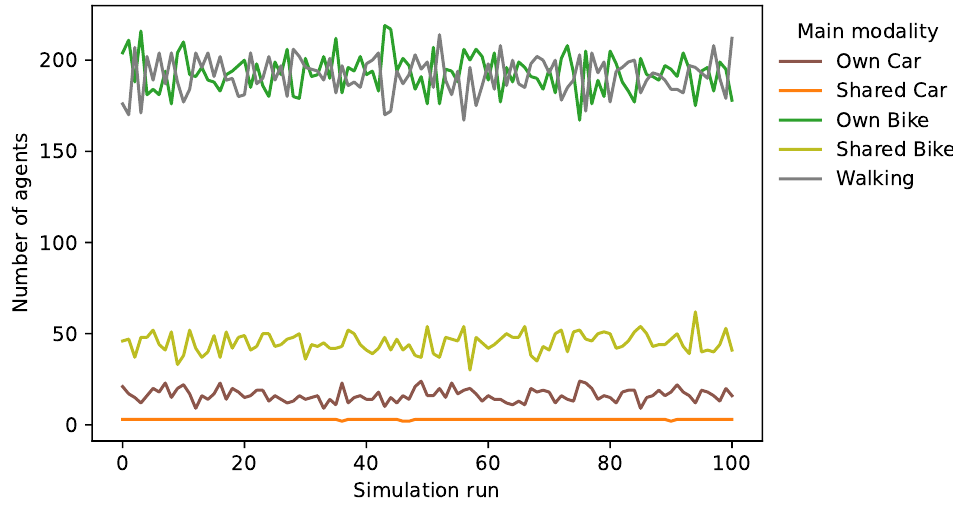
Figure 11. Number of agents that chose each modality to be the main modality across 100 simula- tion